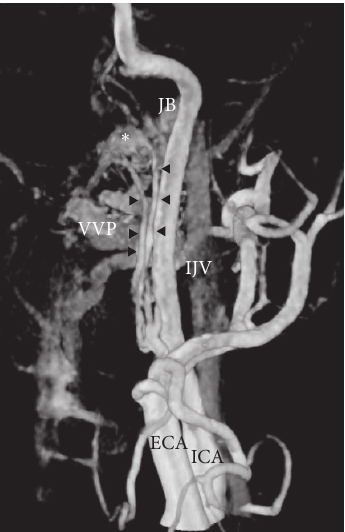
Figure 3: Three-dimensional digital subtraction angiography revealedangioarchitecturesurroundingtheanteriorcondyleconflu- ence dural arteriovenous fistula. Meningeal branches of ascending pharyngeal artery feed to anterior condyle confluence forming venouspouch( ∗ ).Jugularvalve(JV),internaljugularvein(IJV),and vertebral artery venous plexus (VAVP) formed venous drainage.